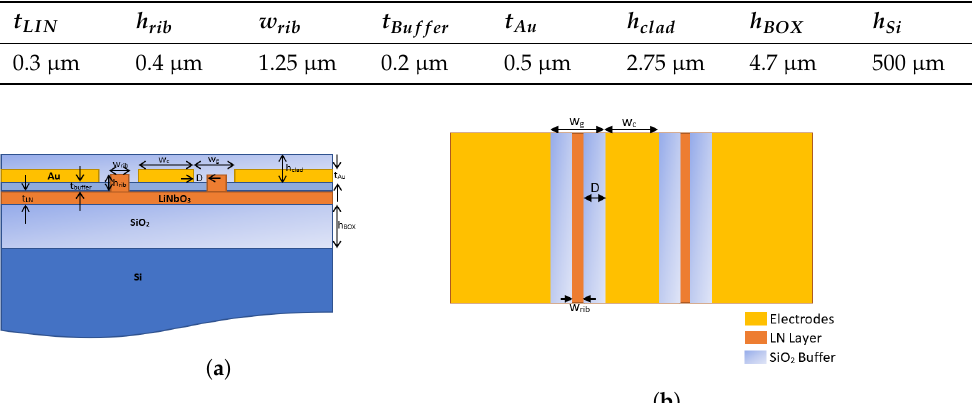
Table 1. Dimensions of various layers displayed in Figure 1.